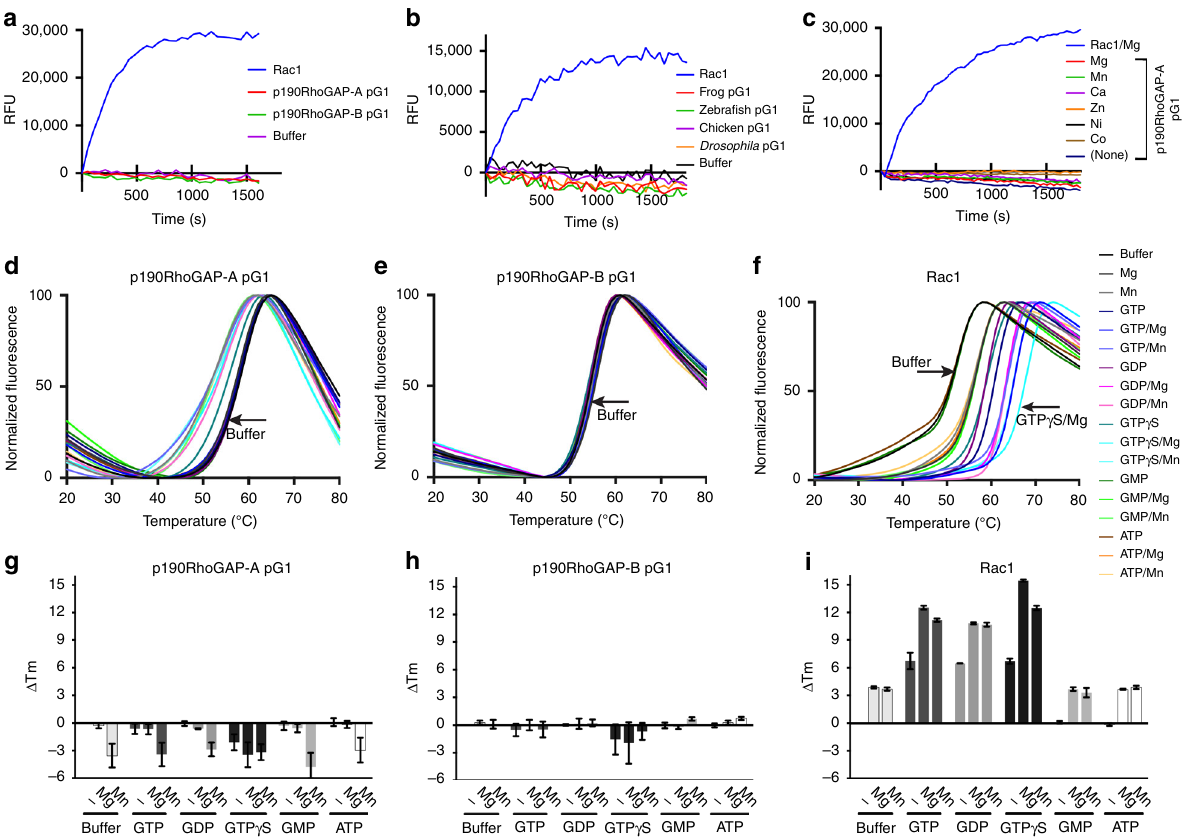
Fig. 4 Assessment of nucleotide binding by p190RhoGAP pG1. a – c Fluorescence of MANT-GTP γ S monitored over time upon addition of proteins as indicated. a pG1 from 190RhoGAP-A or -B, or Rac1 as a control, in the presence of 20 mM EDTA plus 10 mM MgCl 2 . b p190RhoGAP-A pG1 of Xenopus laevis (frog), Gallus gallus (chicken) and Danio rerio (zebra fi sh) or the single p190RhoGAP of Drosophila melanogaster . c p190RhoGAP-A pG1 in the presence of different divalent cations. Rac1 in Mg 2+ is included as a positive control. Uncorrected for photobleaching. d – i Thermal shift assay. d – f Thermal denaturation curves (from a representative experiment) of pG1 domains or Rac1 in the presence of divalent cation, nucleotide or both as listed in f . Buffer alone curves ( black ) are labeled with arrows . g – i Histograms of melting temperature changes ( Δ T m ) compared to buffer alone, determined by fi tting the thermal denaturation curves ( d – f ) to a sigmoidal model. Error bars indicate s.e.m. ( n = 3). Positive shifts indicate a stabilization in the presence of